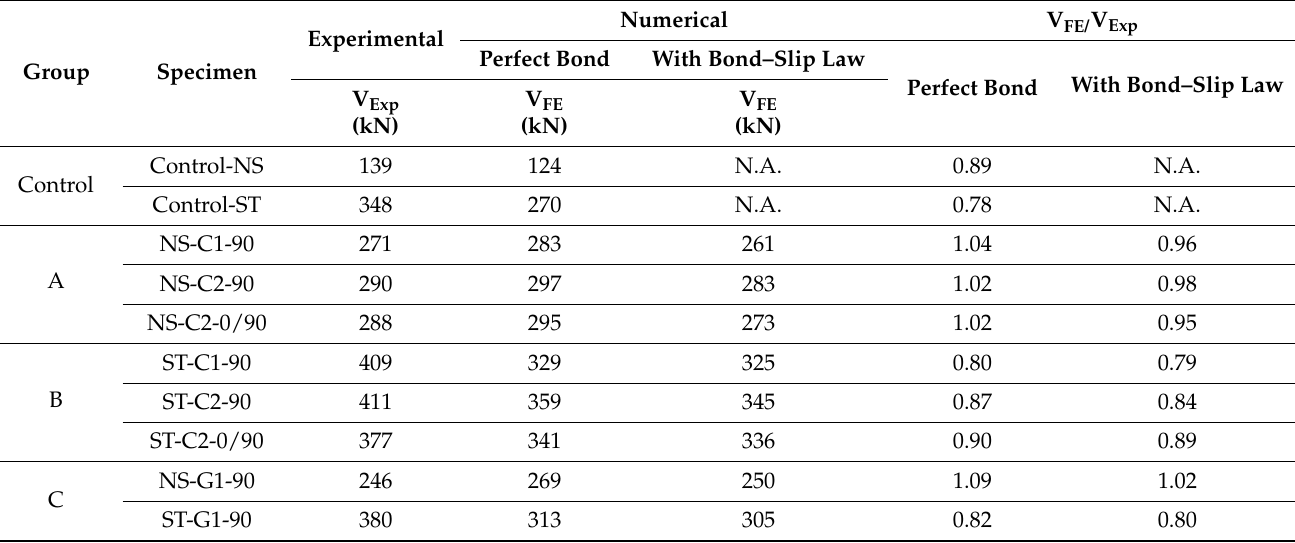
Table 11. Comparison between predicted and measured shear